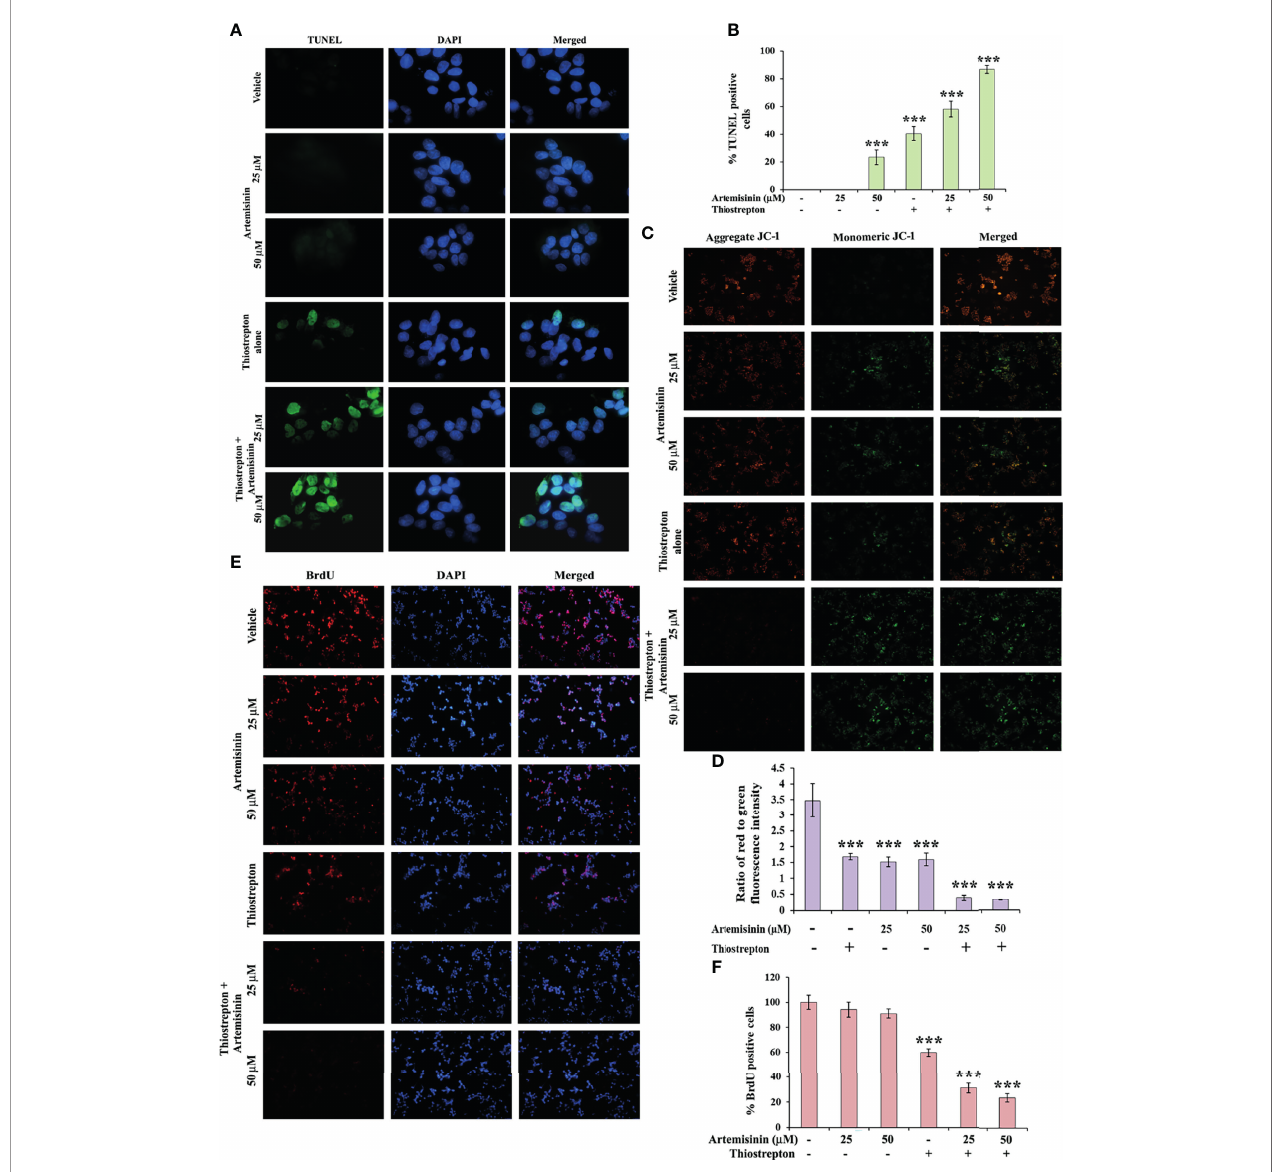
FIGURE 6 | Artemisinin-induced cell death is accelerated by Thiostrepton. (A) Representative images (100X magni fi cation) of TUNEL assay in HepG2 cells incubated with Artemisinin alone or in conjunction with Thiostrepton for 48 h are shown. (B) The percent apoptotic cells are graphically reported. (C) Representative images (40X magni fi cation) of JC-1 assay of HepG2 cells treated with Artemisinin alone or in amalgamation with Thiostrepton for 48 h. (D) Graphical presentation of the ratio of measured red to green fl uorescence intensity. (E) Representative images (40X magni fi cation) of BrdU-positive HepG2 cells treated with either of the drugs alone or their combination for 48 h. (F) Graphical depiction of the percentage of BrdU positive cells. *** p < 0.001. All data are expressed as the means ± standard deviations from triplicate experiments. The two-tailed Student ’ s t -test was used to determine whether the differences between vehicle-treated set and Artemisinin-treated set were signi fi